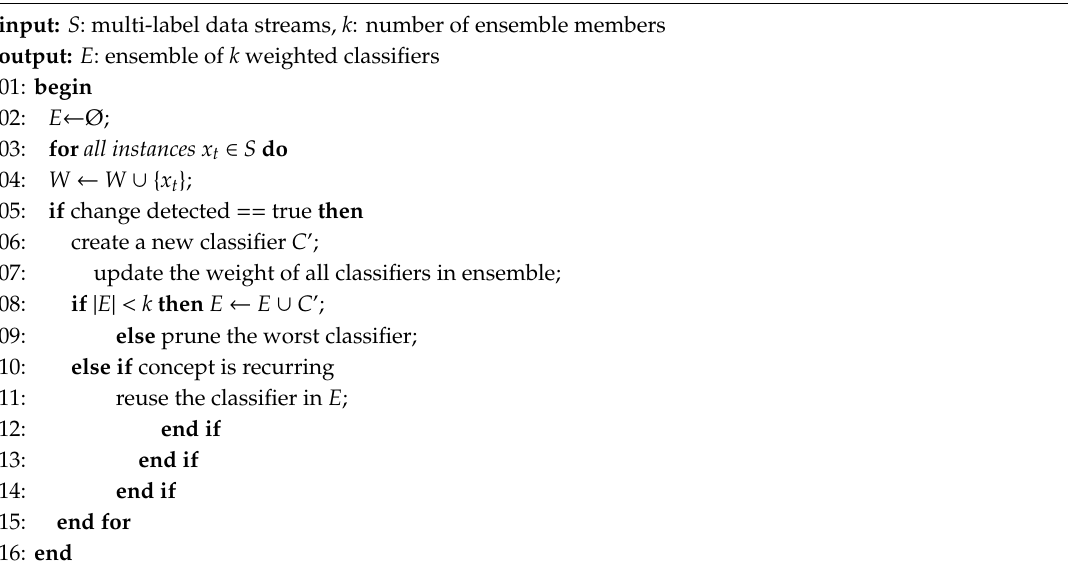
Algorithm 2 MLAW Algorithm.